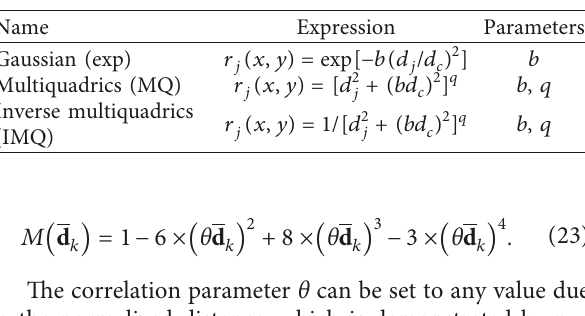
Figure 2: Element support Table 1: Typical radial basis functions.